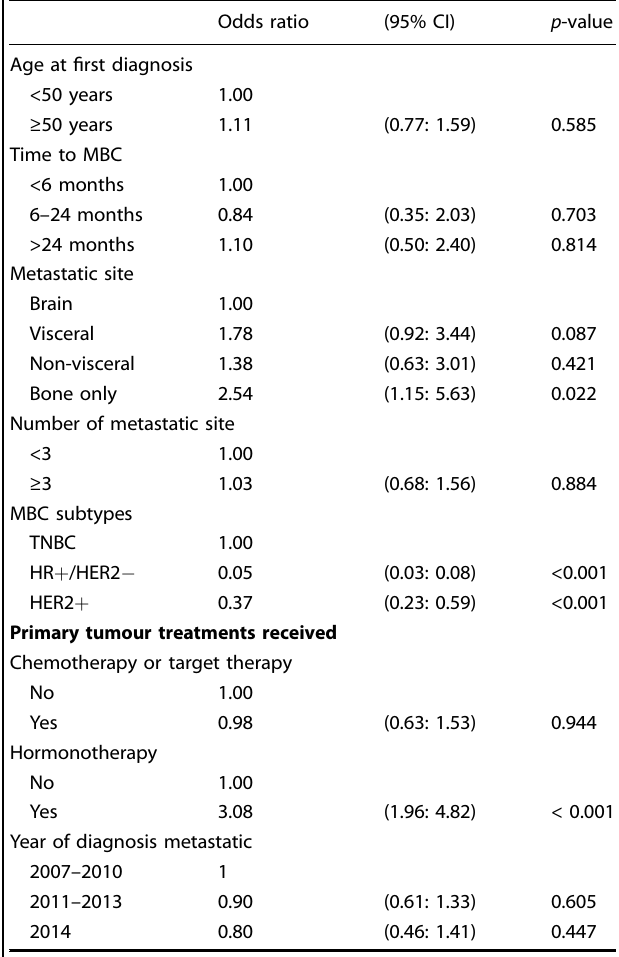
Table 2. Multivariable analysis of factors associated with HR